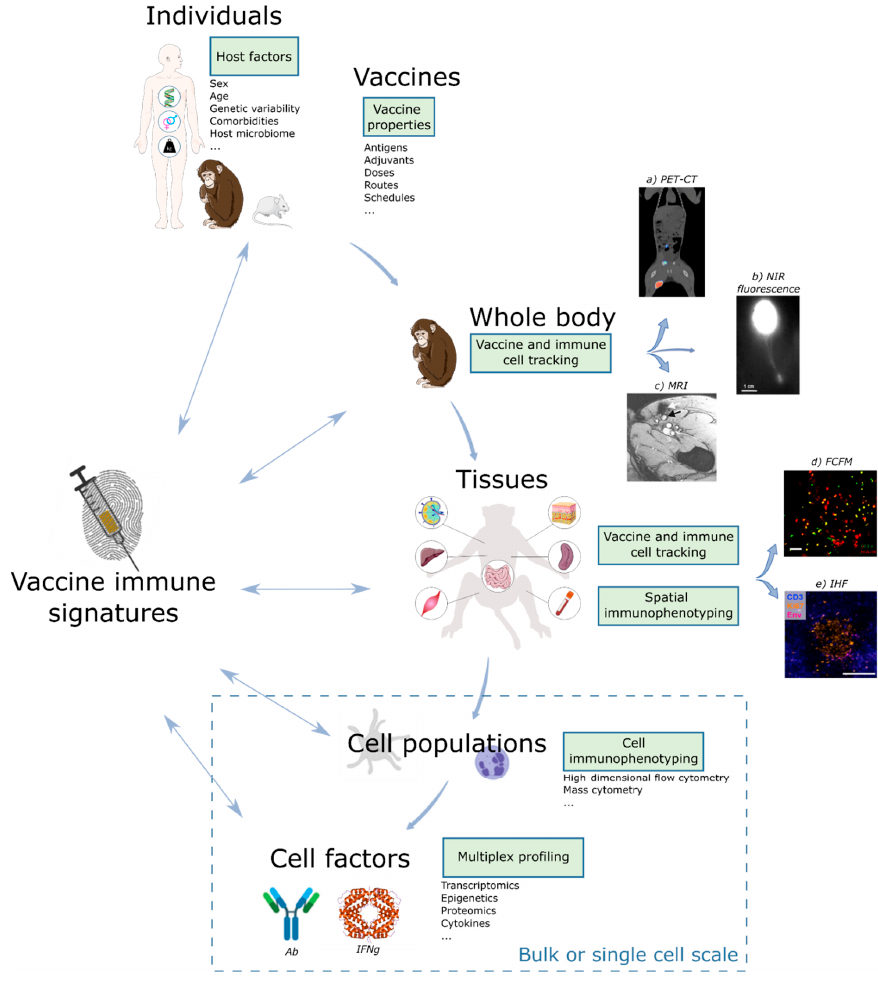
Figure 2. From individuals to single cells: integrating multi-level data into comprehensive vaccine signatures. Host factors and vaccine properties are important determinants of immune responses. Variations of these determinants, such as genetic polymorphisms, age, host microbiome or immunization procedure, thus condition the definition of vaccine signatures. Systems immunology enables the identification of biomarkers of vaccine responses at multiple scales, from whole-body to cellular factors. Diverse high-throughput technologies, including in vivo imaging, allow the characterization of vaccine immune signatures through various applications, such as immune-cell tracking, cell immunophenotyping, and multiplex profiling. Combining and integrating data at different scales will be of great value in identifying extensive vaccine immune signatures. ( a ) Positron emission tomography-computed tomography (PET-CT) imaging of the YF preM mRNA vaccine in NHPs [41] . ( b ) Near-infrared fluorescence (NIR) imaging to follow an anti-Langerin-HIVGag fusion vaccine from the injection site to the draining lymph node [42] . ( c ) Magnetic resonance imaging (MRI) of a DC-based vaccine in the lymph node [43] . ( d ) In vivo tracking of Langerhans cells within the skin b y fibered confocal fluorescence microscopy (FCFM) [44] . ( e ) Tracking of fluorescently labeled HIV-1 envelope glycoprotein trimers in lymph nodes by immunohistofluores- cence (IHF) [45] .